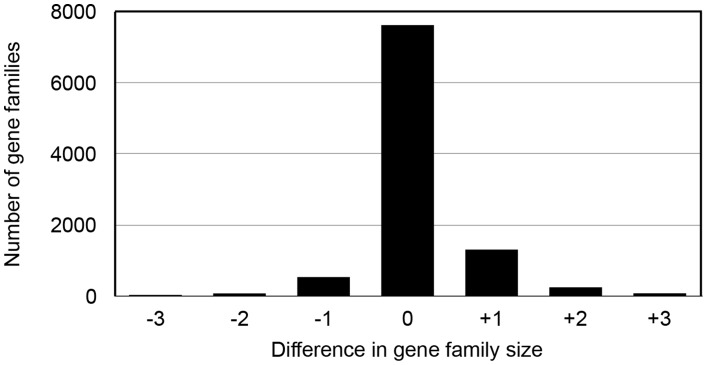
Differences in gene family size when comparing the initial chimpanzee assembly (Pan_troglodytes-1.0) to an updated version (Pan_troglodytes-2.1).Positive numbers indicate an excess number of genes in v1.0, while negative numbers indicate an excess. The small number of gene families with more than +/−3 differences from the reference are not shown.